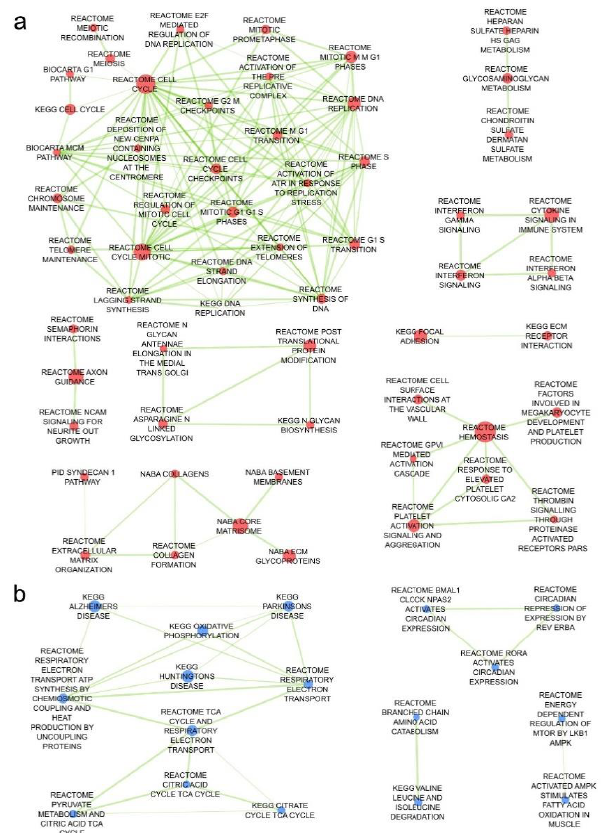
Figure 7. ( a ) Enrichment map of pathways significantly up or ( b ) downregulated in sarcomas versus the other three compared groups. Nodes (pathways) fulfilling filtration criteria, but without connections to other pathways are not shown (39 up- and 6 downregulated in sarcoma). 2.4. Activity of p53 Signaling Pathway Is Dysregulated in Tp53 Knockout Tissues Ingenuity Pathway Analysis (IPA) revealed differences in expression of genes involved in P53 signaling between wild-type and Tp53 knockout rats. In all knockout rats (sarcoma, ko and het groups) the Tp53 gene itself is slightly, but insignificantly, downregulated (Figures S3–5 and Table S2). The presence of Tp53 transcripts, detectable by microarray assay, can be expected in this model, since loss of functional p53 is caused by point mutation, which results in the lack of p53 protein, but not necessarily lack of its mRNA. In the Het group majority, some—but not all—of the genes directly downstream of Tp53 were downregulated, especially the ones responsible for DNA repair, which indicates that their activation by p53 was indeed suppressed. A similar transcriptomic profile was observed in Ko rats, in which, again, a substantial number of genes activated by p53 was downregu- lated in comparison to wild-type rats. In the sarcoma group, the activity of some of these genes seemed to be restored despite the presence of mutated Tp53 . On the other hand, some genes respon- sible for cell cycle arrest were downregulated even in rats, which was consistent with our GSEA result that showed activation of cell cycle-associated pathways. 3. Discussion Several p53-deficient animal models have been developed to mimic sarcomagenesis. In particu- lar, mice with Tp53, inactivated by Cre-loxP-mediated recombination, develop spindle cell sarcomas